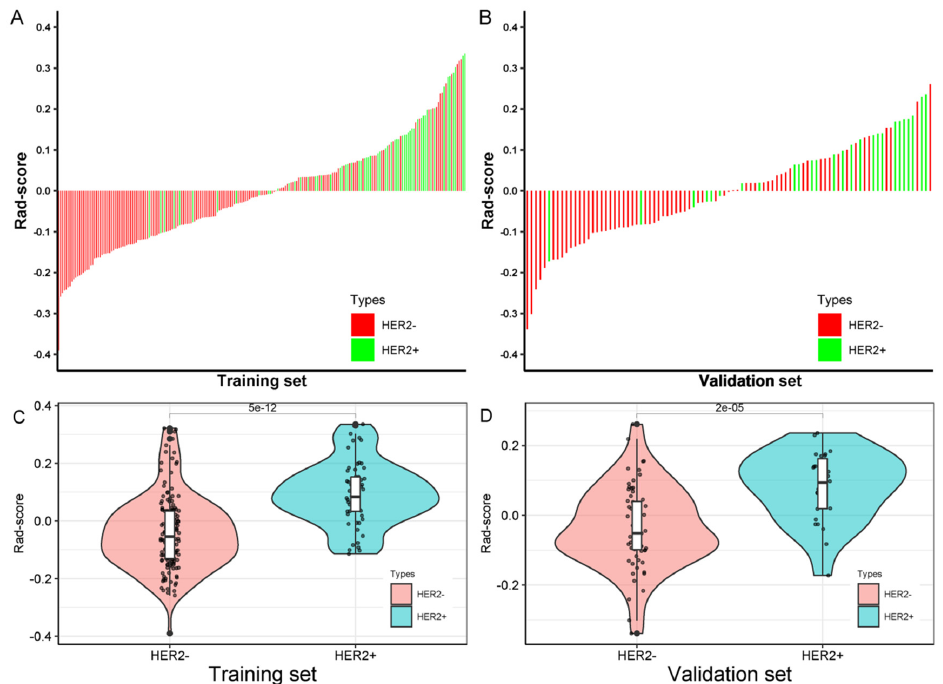
Figure 6. Radiomics score for each breast carcinoma patient in the training ( A ) and validation sets ( B ); Distribution of radiomics score values of the HER2+ and HER2 − groups in the training ( C ) and validation sets ( D